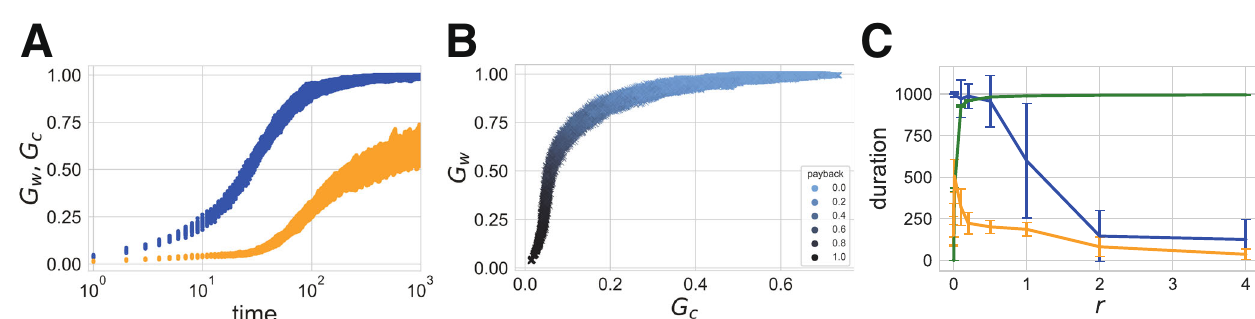
Fig. 1 Simulation result of the basic model. A Temporal change of Gini coef fi cients for wealth (blue) and connectivity (orange). The graph presents the results of 100 trials. B Scatter plots of Gini coef fi cients at each time step. The marker colour indicates the percentage of appropriate reciprocation made for the gift at that time. The lighter colour shows that fewer gifts are reciprocated. C The average duration of individuals being `free' (blue), `repaying' (green), and `rich' (orange), depending on the interest rate for reciprocation r . Error bars show the standard deviations of 100 trials. `Free' indicates that people are not in the process of repayment, `repaying' indicates that they are in that process, and `rich' indicates that they are in the top 5% of wealthy individuals in society. r equals 0.1 in A and B